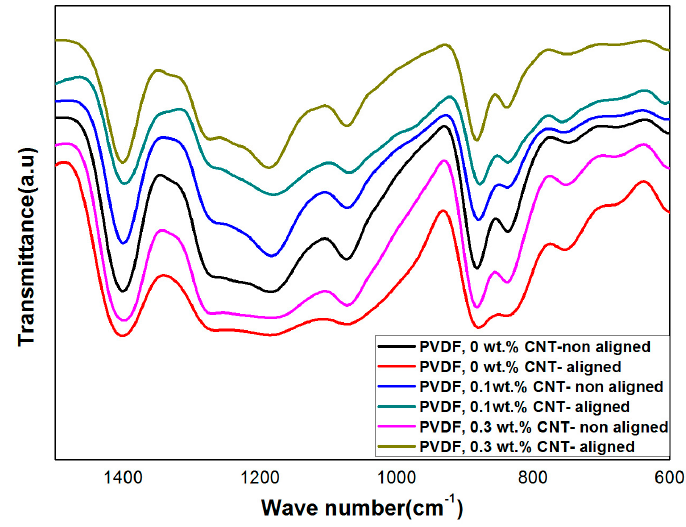
Figure 9. FT-IR analysis for both aligned and non-aligned PVDF nanofiber.